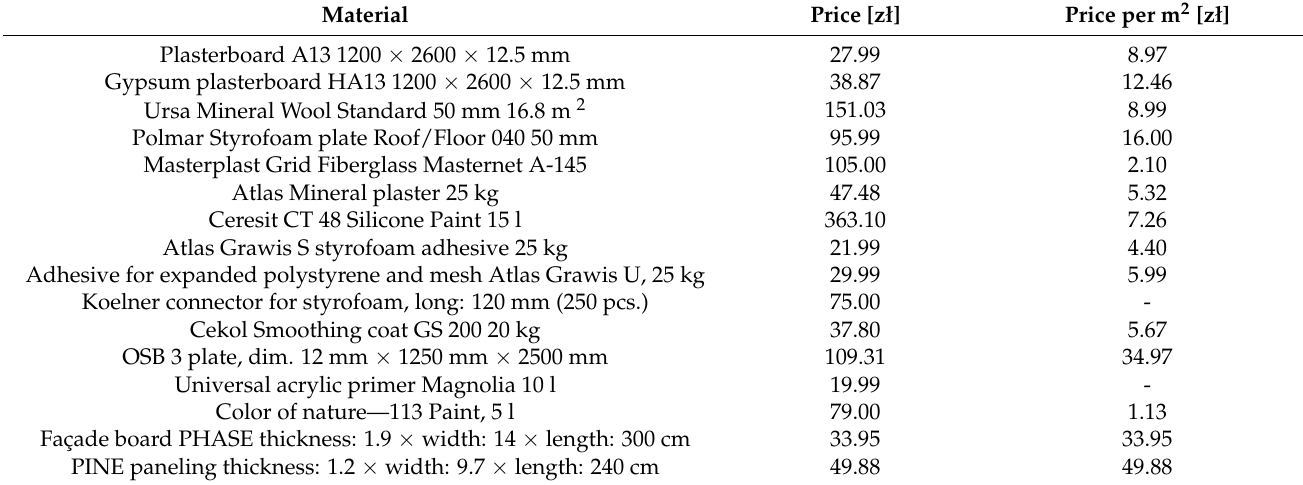
Table 1. Cost of the individual materials used for manufacturing external/internal walls in Polish